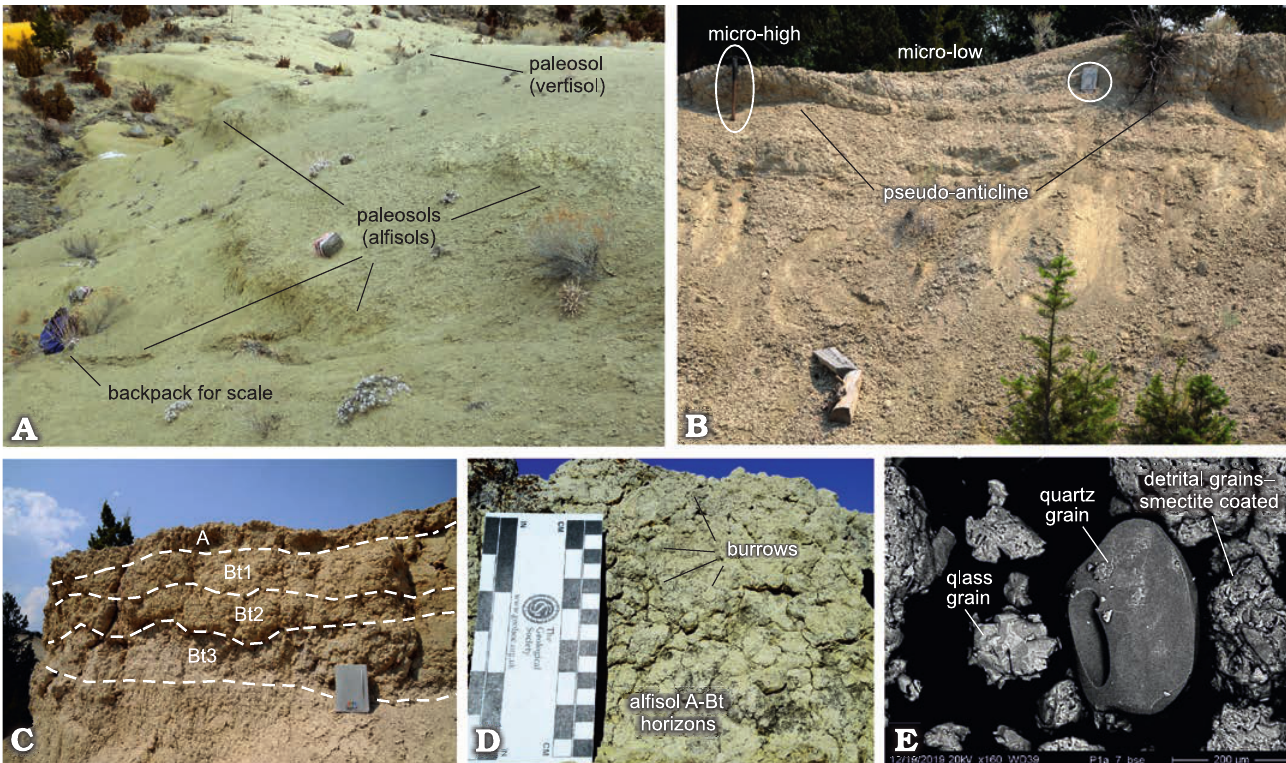
Fig. 6. Paleosol features and grain morphology of the Pipestone Springs strata. A . Alfisols occur as rubbly zones that weather to become resistant units from approximately 12–40 m in the Pipestone Springs reference section. These paleosols are composite and are developed upon extensively reworked volcanic glass and non-volcanic grains. A vertisol occurs atop the 36.00±0.20 Ma upper lapilli tuff at Pipestone Springs. Backpack is 50 cm in length for scale. B . The Pipestone Springs basal lapilli tuff, with a 40 Ar/ 39 Ar age of 37.50±0.02 Ma, is a direct ashfall tuff and is partially overprinted by a vertisol paleosol. The vertisol contains pseudo-anticlines and micro-highs and lows. Scale for paleosol features is the circled field notebook at 19 cm in length and the shovel at 54 cm in length. C . Alfisols are the most numerous paleosols within Pipestone Springs strata. These paleosols have composite A–Bt1–Bt2– Bt3 profiles. Field notebook is 19 cm in length for scale. D . Alfisol A–Bt horizons are delineated primarily by the occurrence of abundant trace fossils. E . Backscattered electron microscopy image of sample P1a_7, taken from near the base of the Pipestone Springs reference section (sample location shown in the stratigraphic column of Fig. 4), shows volcanic grains (a glass grain indicated by arrow) mixed with detrital non-volcanic components (magnifi- cation ×160). A conspicuous rounded and pitted quartz grain is indicated by the white arrow. Overall grain morphology is rounded to subangular, with substantial smectitic clay overgrowth on most grains (indicated by arrow for one